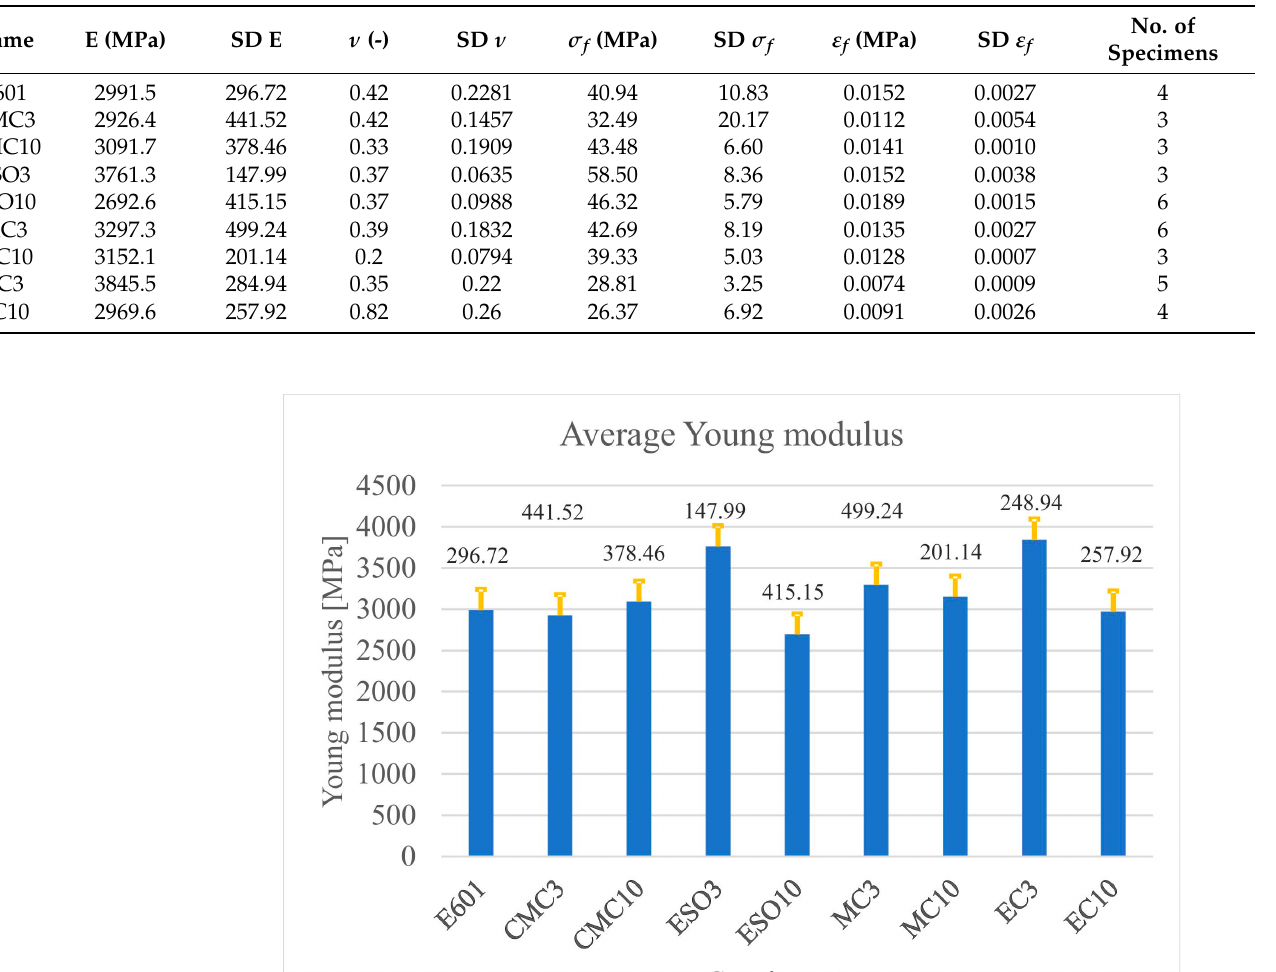
Table 3. Average values of Young’s modulus, Poisson’s ratio, failure stresses and strains, and the number of specimens.